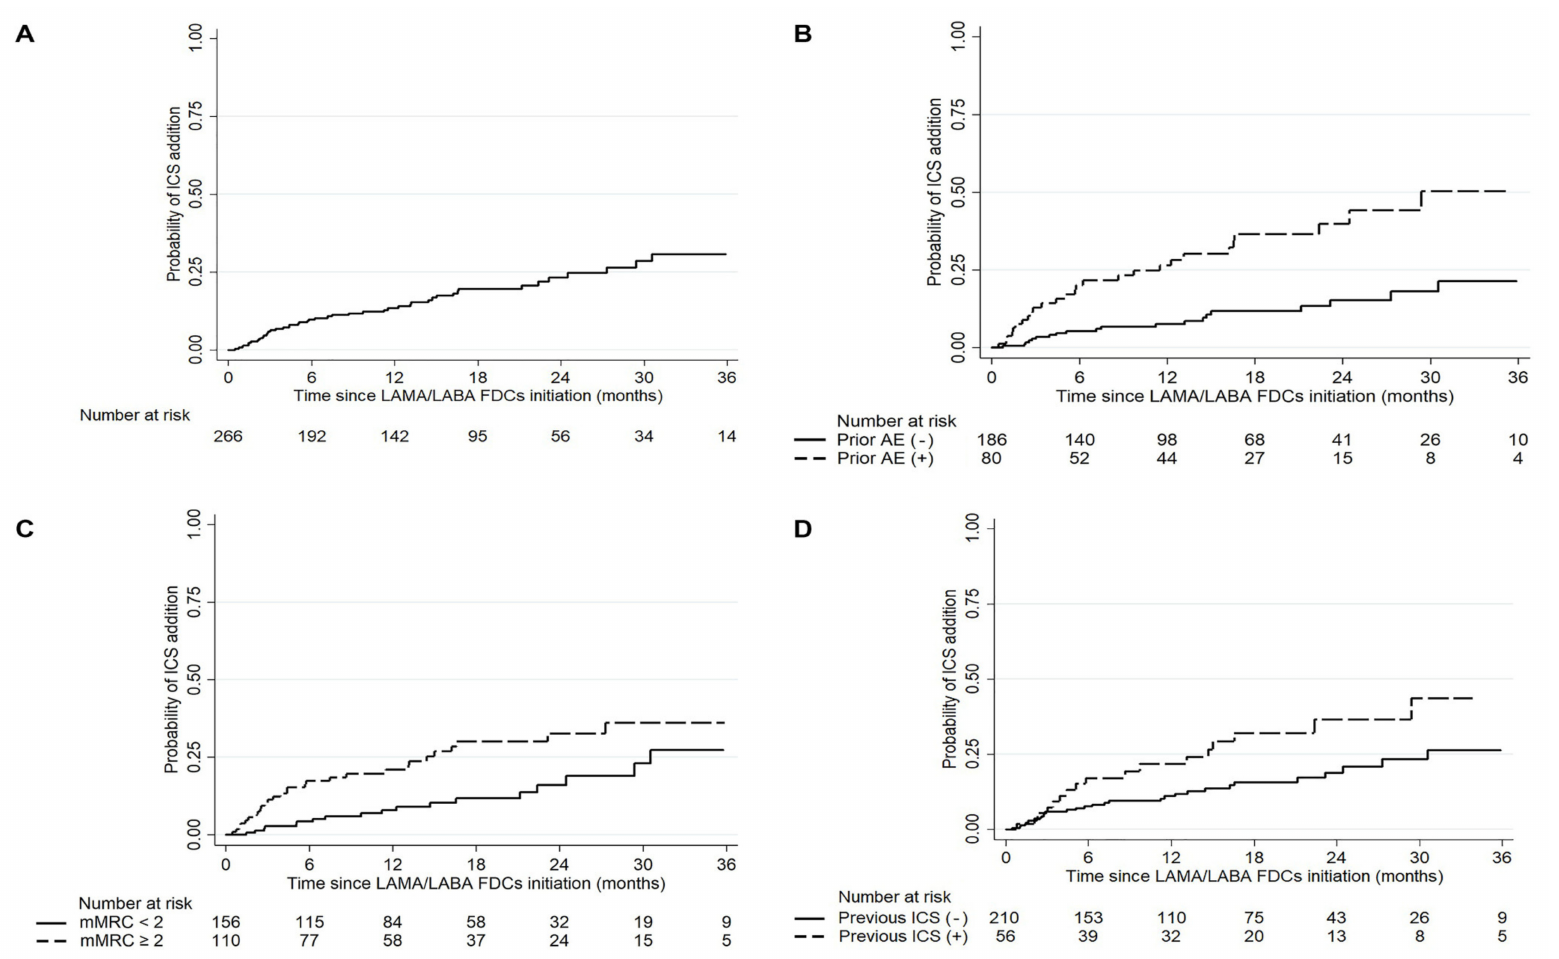
Figure 2. Kaplan–Meier curves for ICS addition in ( A ) overall patients and by ( B ) exacerbation in the previous year, ( C ) baseline dyspnea of mMRC ≥ 2, and ( D ) previous ICS use. FDC, fixed-dose combinations; ICS, inhaled corticosteroids; Prior AE, acute exacerbation in the previous year; LABA, long-acting beta2-agonist; LAMA, long-acting muscarinic antagonist; mMRC, modified medical research